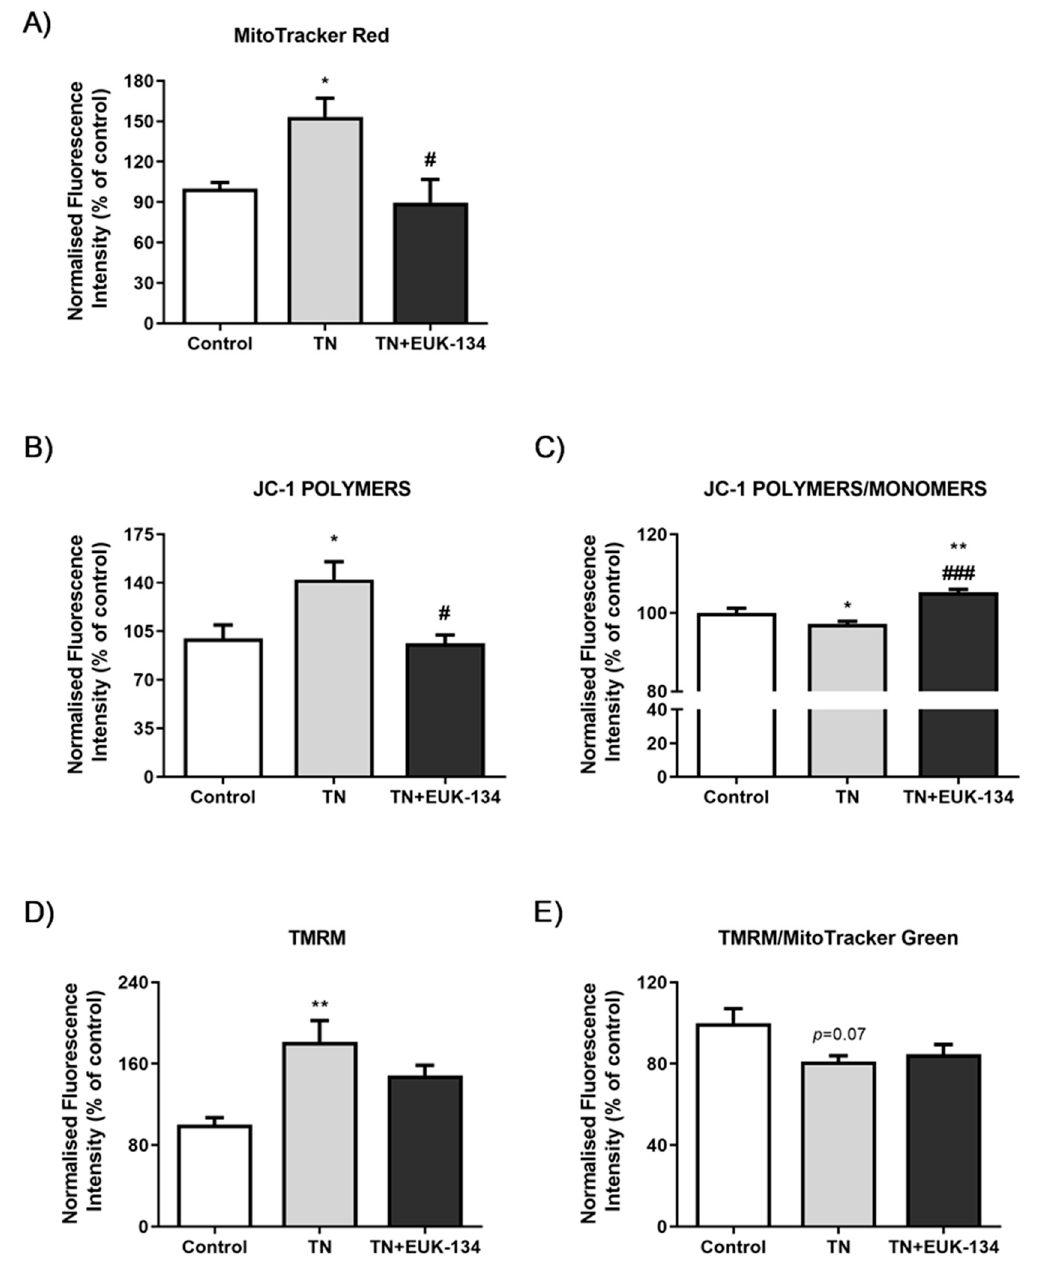
Figure 3. Mitochondrial membrane potential of tunicamycin-treated cells with or without EUK-134. Relative change (%) in ( A ) MitoTracker Red CMXRos fluorescence intensity ( n = 4), ( B ) JC-1 red fluorescence (polymers) intensity ( n = 8), ( C ) JC-1 red to green fluorescence (polymers / monomers) intensity ( n = 8), ( D ) TMRM fluorescence intensity ( n = 4), and ( E ) TMRM per MitoTracker Green (mitochondrial mass / volume) fluorescence intensity ( n = 4), normalised to protein content. Data represent the mean ± SEM, * p ≤ 0.033, ** p < 0.002, and *** p < 0.001 against vehicle control or tunicamycin alone (#).